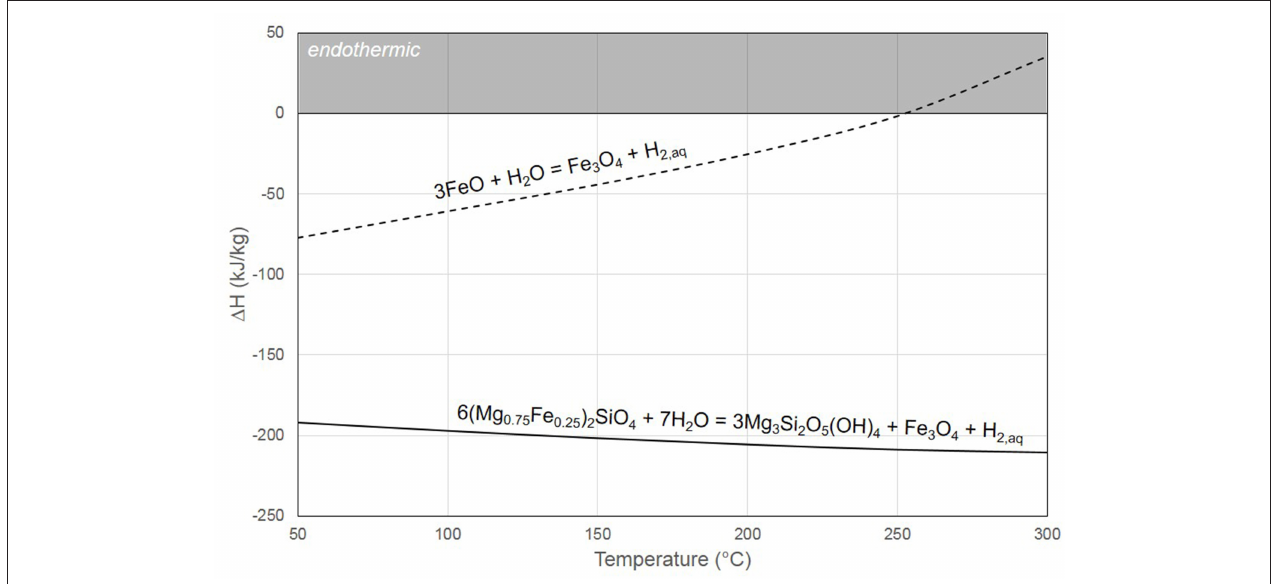
FIGURE 6 | Enthalpy of reaction in kJ per kg of starting material (including H 2 O) at 20 MPa as a function of temperature. Whereas, serpentinization is strongly exothermic in the considered temperature range, wüstite oxidation in the presence of water becomes endothermic above 250 ◦ C.